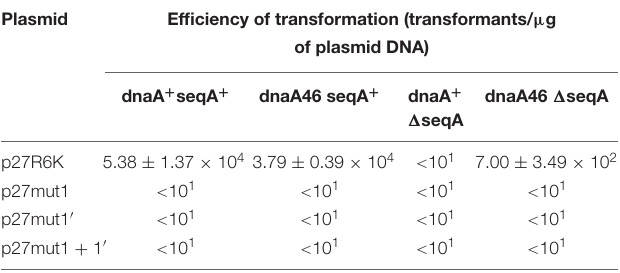
TABLE 2 | Transformation efficiency of E. coli wild-type, dnaA, seqA, and dnaA seqA hosts by derivatives of p27cmr plasmids bearing mutated iteron sequences 1 and 1 (cid:48) at 30 ◦ C. Results are presented as mean values of three independent experiments ± SD.